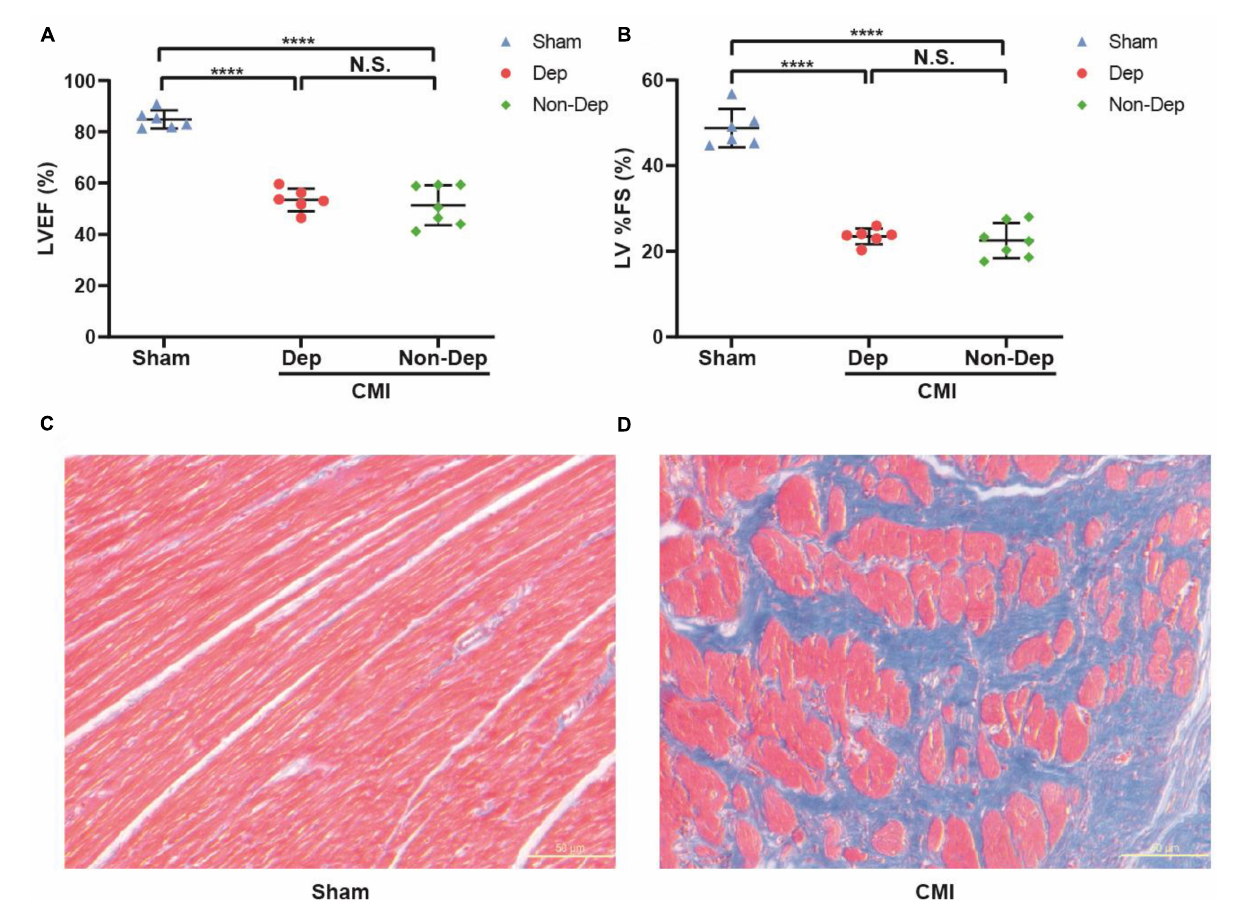
FIGURE 2 | Cardiac function evaluated by echocardiography and comparisons of cardiac morphology between sham rats and CMI rats. (A) LVEF. (B) LV%FS. (C) Masson staining in the left ventricular cardiomyocytes extracted from sham rats. (D) Masson staining in the left ventricular cardiomyocytes extracted from CMI rats. **** p < 0.0001; N.S., not significant. Data are shown as mean ± SEM. ( n = 6–7) by one-way ANOVA. CMI, chronic myocardial infarction; Dep, depression-like behavior; Non-Dep, non-depression-like